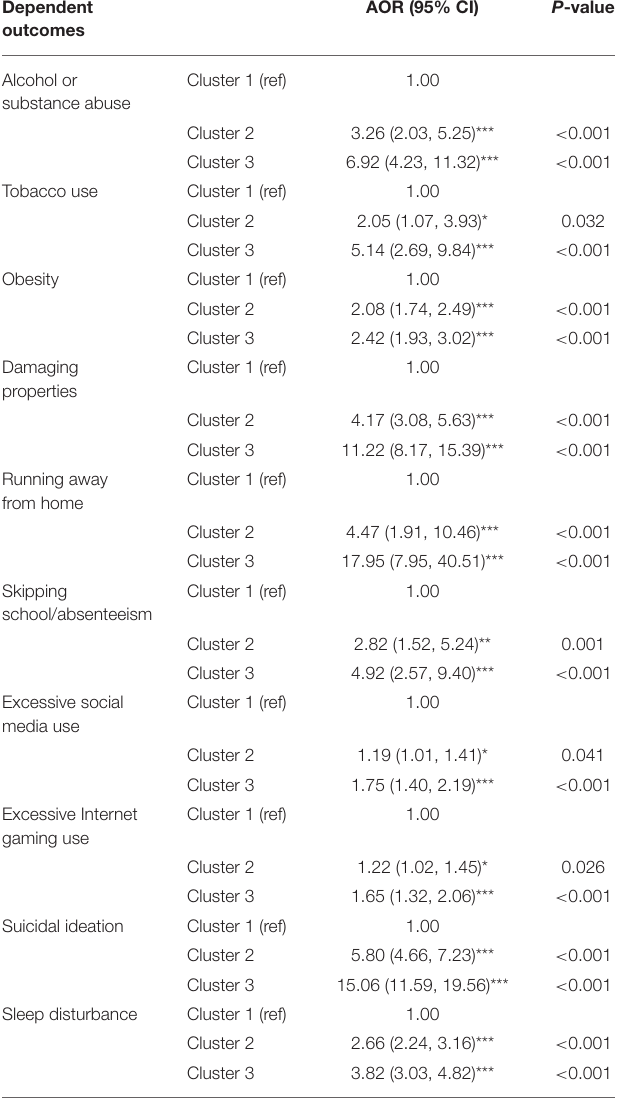
TABLE 2 | Associations between cluster membership and behavioral, Internet use, and mental health problems. Dependent